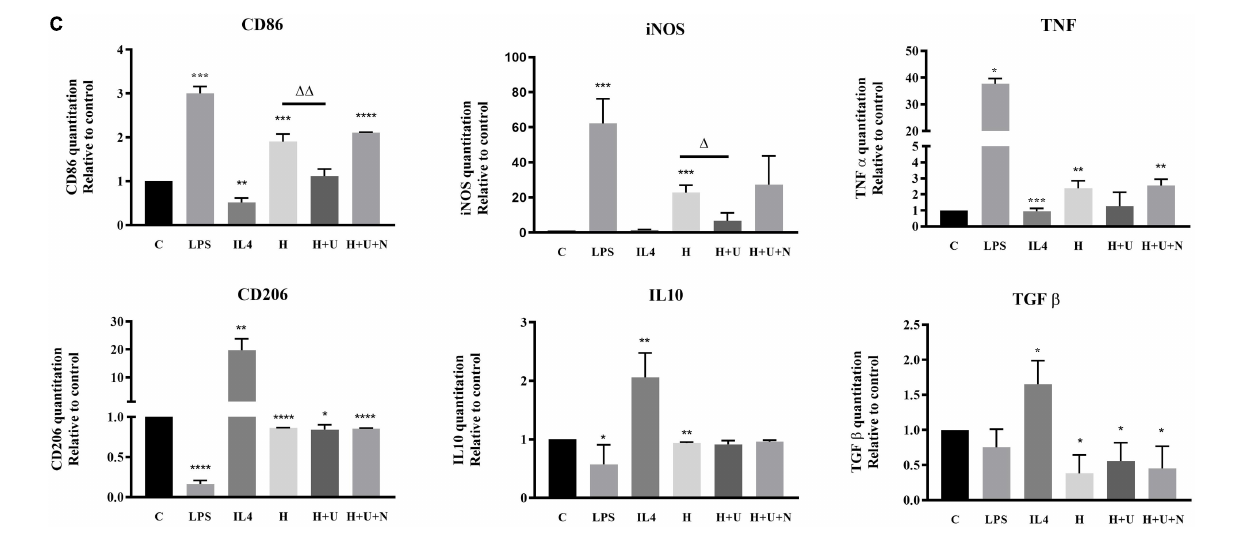
FIGURE 3 | δ -opioid receptor (DOR) regulation of inflammatory cytokines and anti-inflammatory cytokines under LPS, IL4, or hypoxic condition. The mRNA levels of CD86, iNOS, TNF- α , CD206, IL10, and TGF- β were measured by RT-PCR in BV2 cells under LPS/hypoxic insults ( N ≥ 3 in each group). (A) Effects of DOR activation on inflammatory events under LPS insult. * p < 0.05, ** p < 0.01, *** p < 0.001, **** p < 0.0001 vs. C; (cid:49) p < 0.05, (cid:49)(cid:49) p < 0.01 vs. L. Note that 10–20 µ M of UFP-512 significantly inhibited the M1 type shift of BV2 cells under LPS insult, as well as downregulating iNOS and TNF. (B) DOR-mediated suppressions of anti-inflammatory events in IL4-treated BV2 cells. * p < 0.05, ** p < 0.01, *** p < 0.001, **** p < 0.0001 vs. C; (cid:49) p < 0.05, (cid:49)(cid:49) p < 0.01 vs. I. Note that IL4 caused a significant increase in M2 phenotype marker CD206 and anti-inflammatory cytokines IL-10 and TGF- β . Following the increase of UFP-512 concentration, the IL4- mediated anti-inflammatory events were attenuated. (C) Effects of DOR activation on inflammatory events under hypoxic stress. * p < 0.05, ** p < 0.01, *** p < 0.001, **** p < 0.0001 vs. C; (cid:49) p < 0.05, (cid:49)(cid:49) p < 0.01 vs. H. Note that the hypoxia-induced upregulation of CD86, iNOS and TNF- α were inhibited by DOR activation with UFP-512, while the addition of naltrindole reversed these